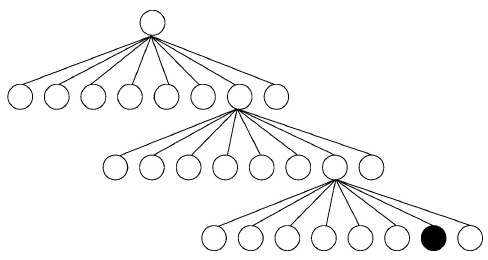
Figure 2. Schematic diagram of data organization of